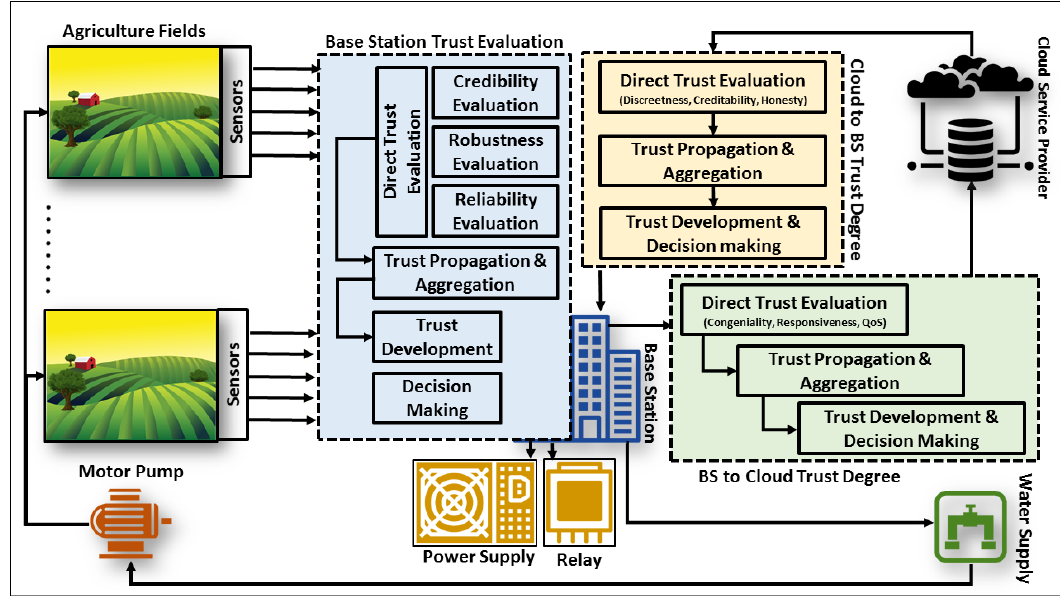
Figure 2. The AgriTrust